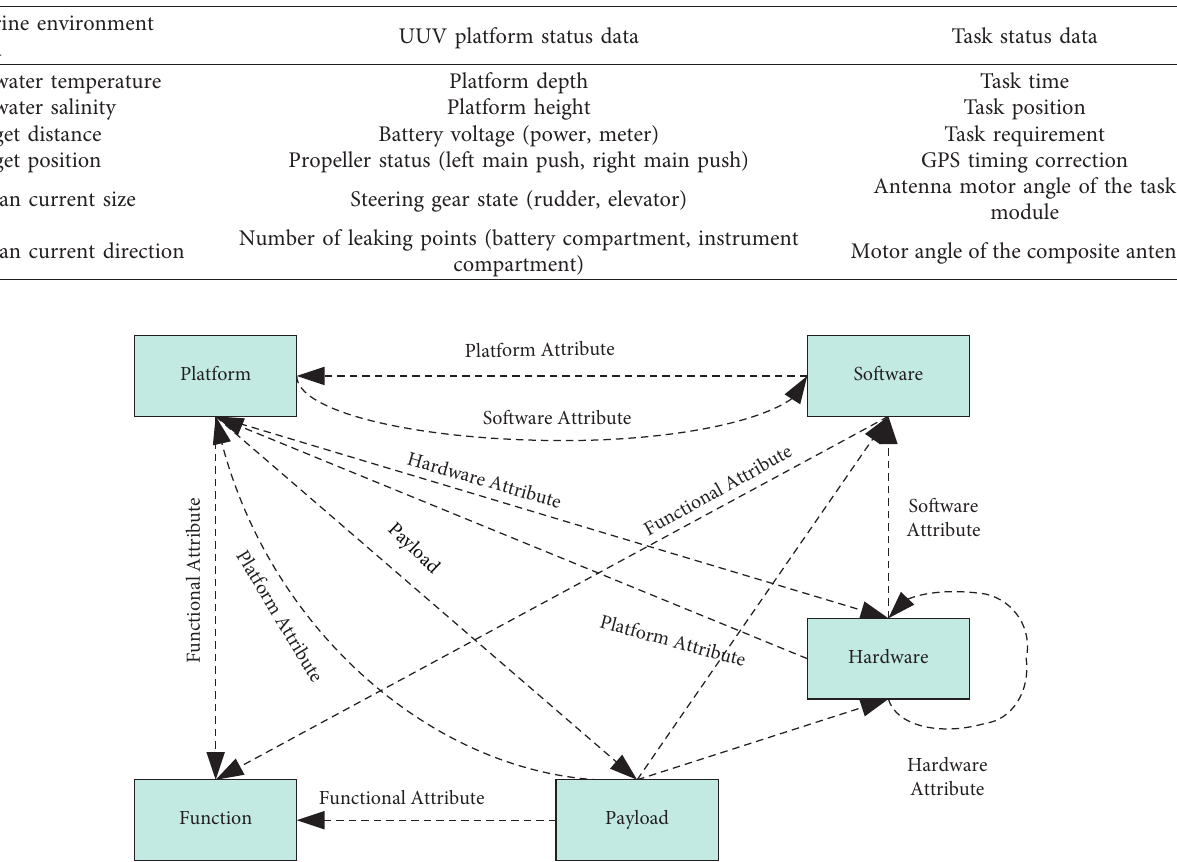
Table 1: The UUV detection data according to the types of uncertain events.